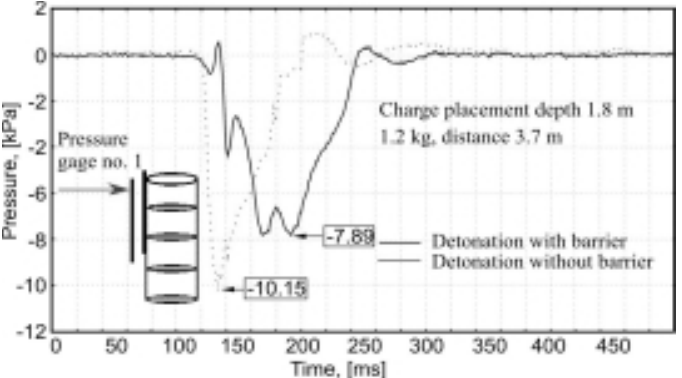
Fig. 13. Time histories of pressures p h on the structure front, measured by gage No. 1 from a detonation at 3.7 m from the silo. 5.7 m (shot No. 4) are considerably smaller than for 4.7 m (shot No. 3) and 3.7 m (shot No. 6), and are related to